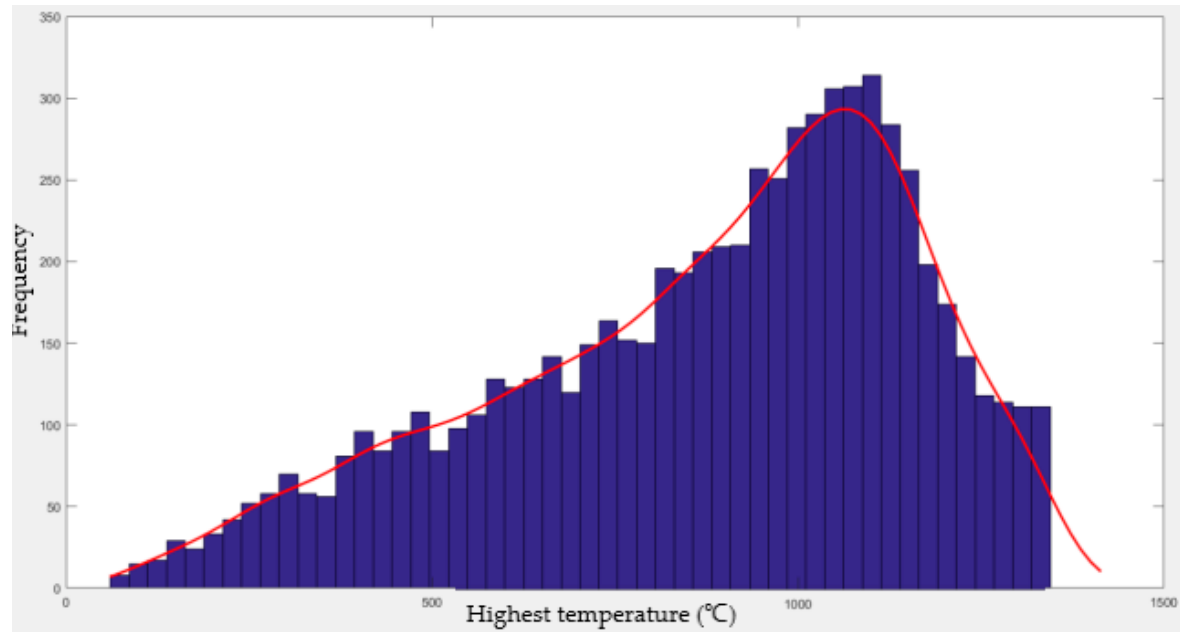
Figure 9. Probability distribution histogram of highest temperature.